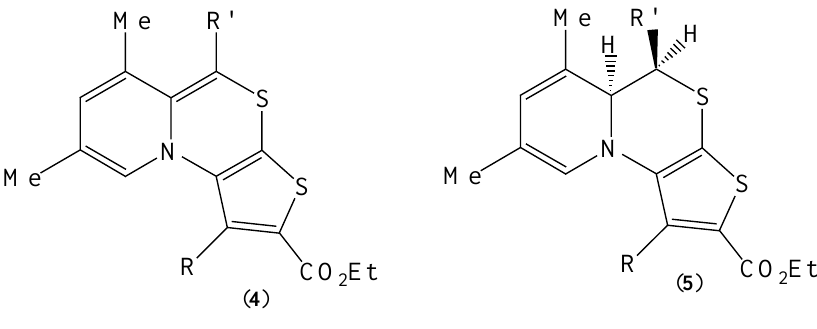
Figure 2. Structures of pyrido[2,1-c]thieno[3,2- e ][1,4]thiazines 4 , 5